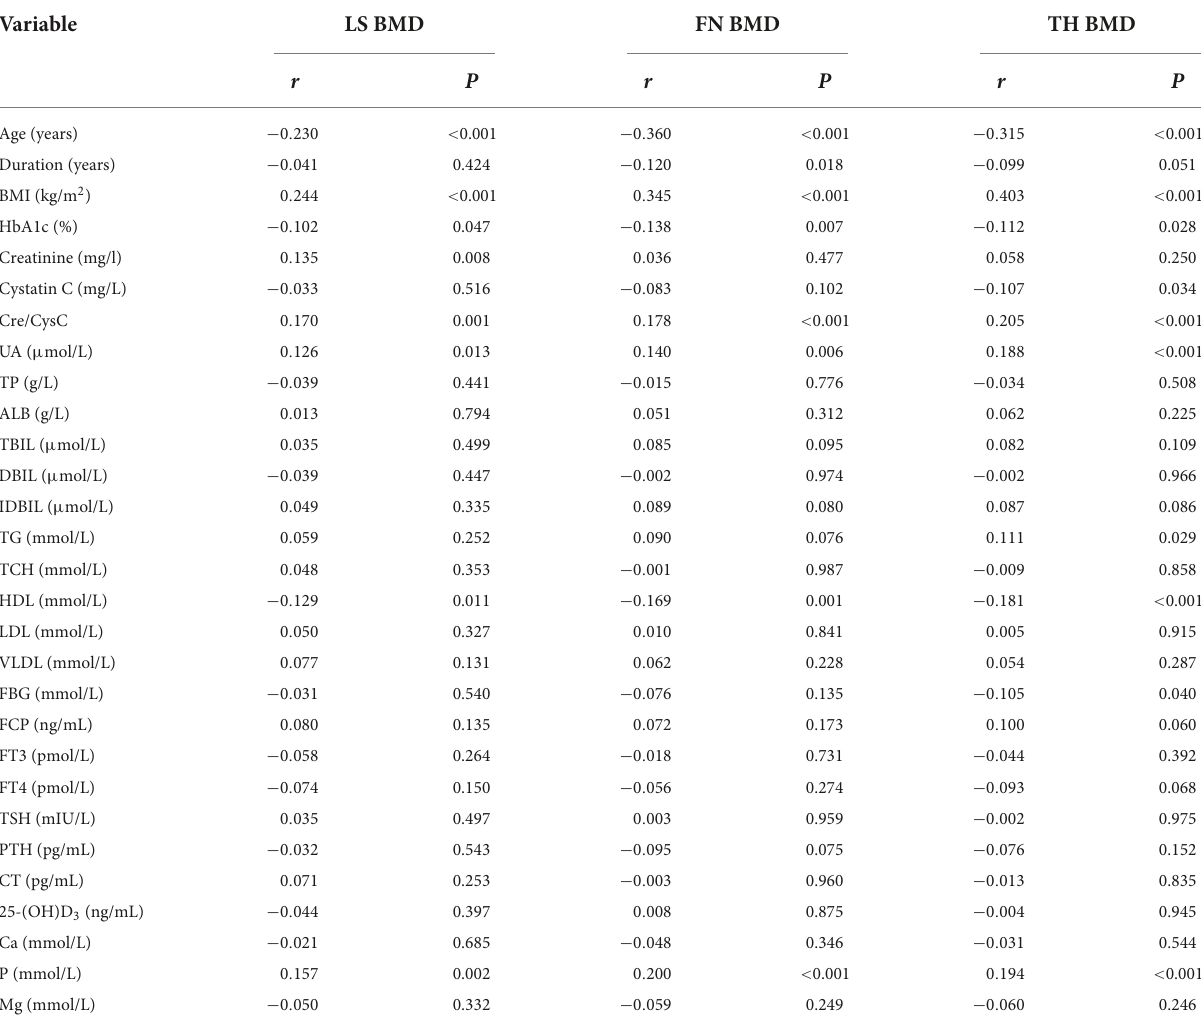
TABLE 2 Correlations between clinical factors and